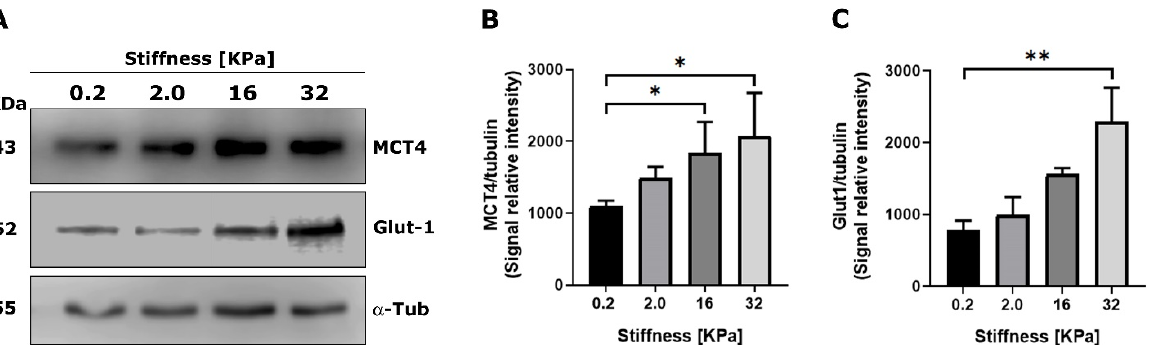
Figure 3. Extracellular matrix stiffness modulates the expression of monocarboxylate transporters in mammary stromal cells. RMF 621 cells (2.5 × 10 5 per plate) were incubated on plates displaying increasing stiffness and coated with collagen I, as described above, in media +10% FCS. Afterward, 72 cells were lysed and Western blots of MCT4 ( A ) and Glut1 ( B ) were performed as described in Section 4. Densitometric analyses of three different experiments were performed from three independent experiments, as shown in ( C ). The data are presented as the means ± standard error (SEM). (*) and (**) indicate statistically significant differences, with p ≤ 0.05 and p ≤ 0.01, respectively, using the Friedman test followed by Dunn’s posthoc